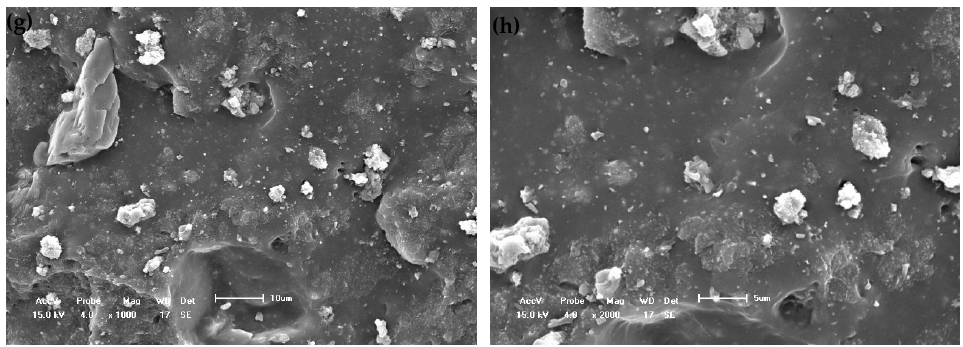
Figure 7. SEM micrographs of the samples: ( a ) 100/0; ( b ) 83/17; ( c ) 71/29; ( d ) 62/38; ( e ) 50/50; ( f ) 45/55; ( g ) 42/58; and ( h ) 42/58 (2000×).